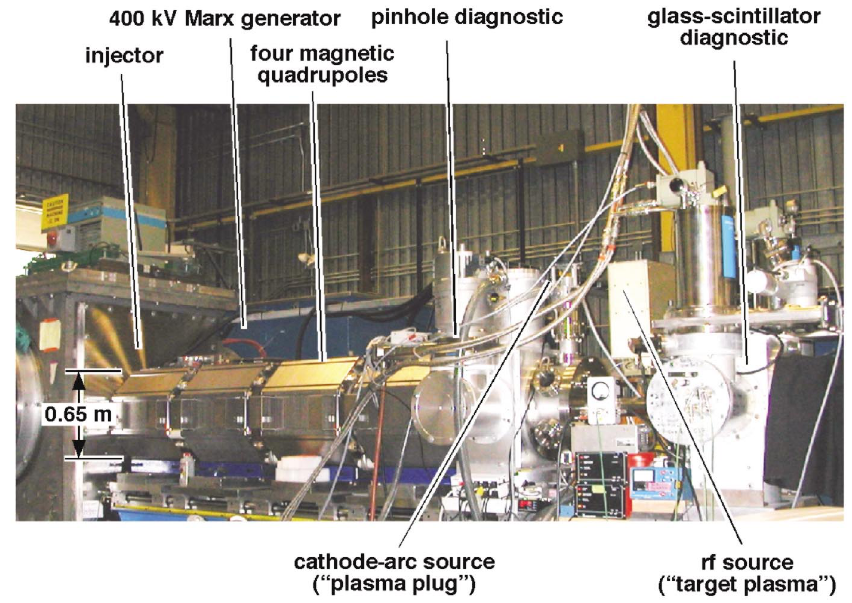
FIG. 1. (Color) neutralized transport experiment